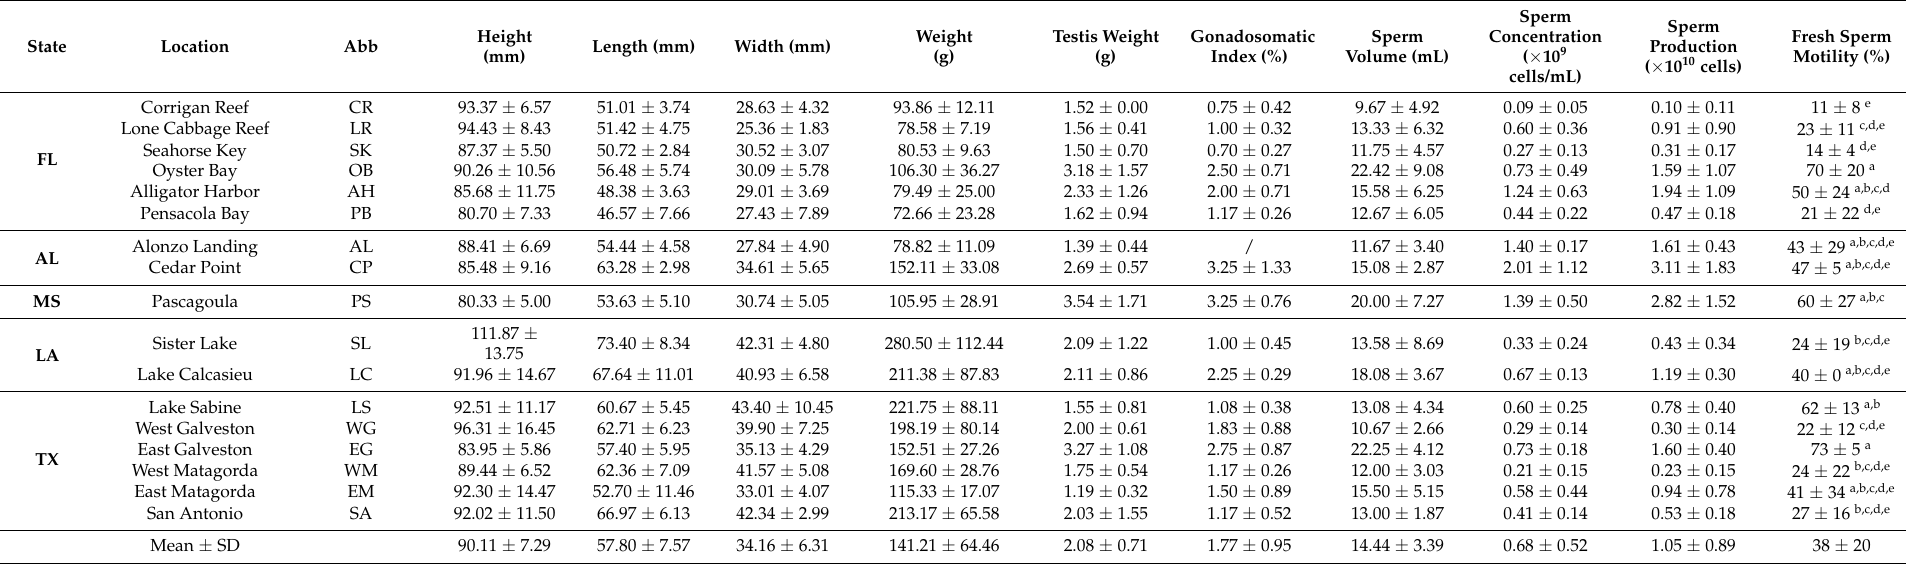
Table 2. Eastern oyster Crassostrea virginica collection location, shell metrics, whole body weight, testis weight, gonadosomatic index (percentage of gonad weight out of the total body weight), total sperm production, and fresh sperm motility (%) used for breeding program and sperm cryopreservation. Significant differences in fresh sperm motility among different collection sites are labeled with different letters (a–e) ( p < 0.050). FL : Florida; AL : Alabama; MS : Mississippi; LA : Louisiana; TX :